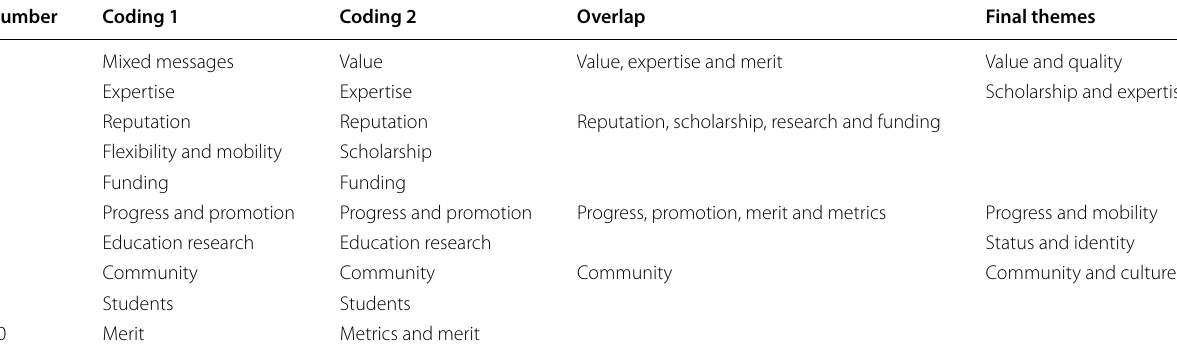
Table 3 Identification of themes, reduction of overlap and redundancies and alignment of themes with Bronfenbrenner’s model Number Coding 1 Coding